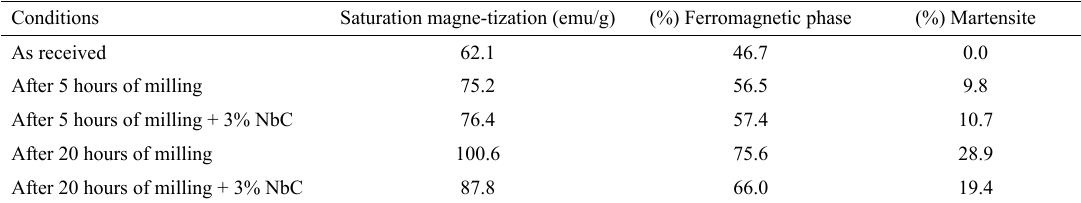
Table 2. Percentage of ferromagnetic phase and phases present in duplex stainless steel under different conditions.